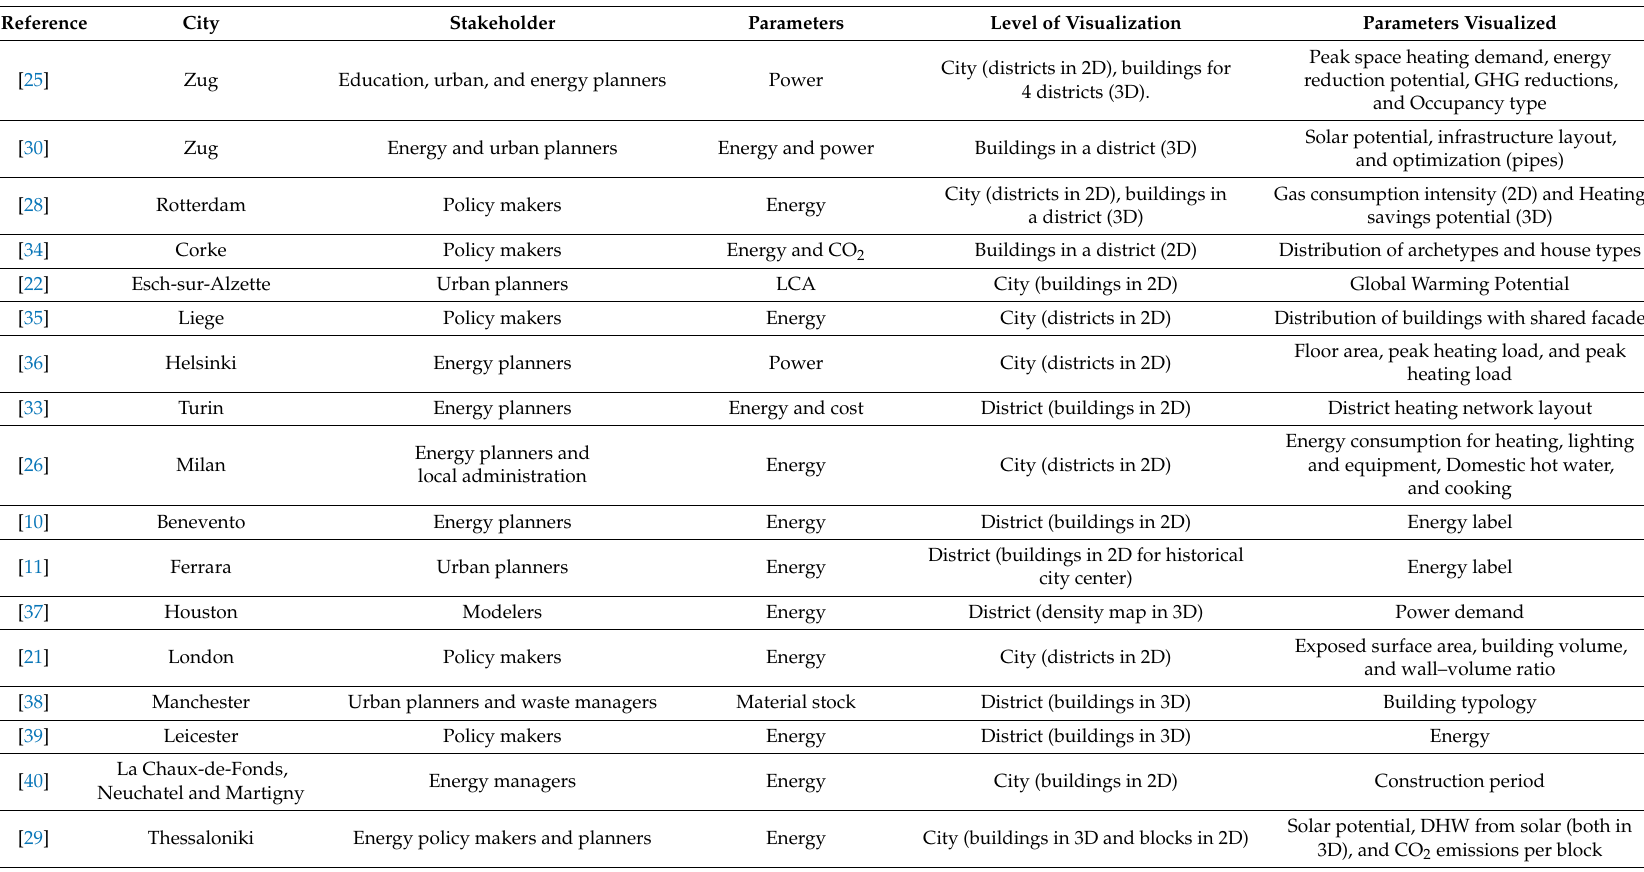
Table 1. Overview of building-stock models (BSM), the city modeled, the stakeholders targeted, the parameters, and